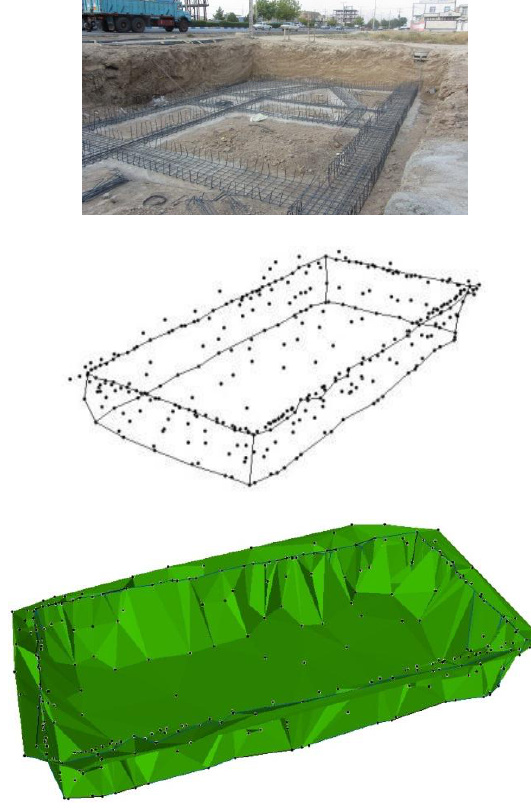
Figure 6. a)Photos of Tower(s) b) Its 3D point clouds with an sketchy model RESULT AND DISCUSSION